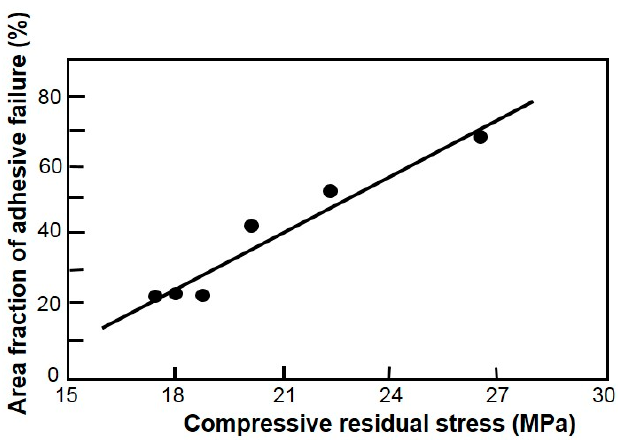
Figure 6. Relation between adhesive failure and compressive residual stresses of plasma-sprayed hydroxylapatite coatings on Ti6Al4V [55]. © With permission by